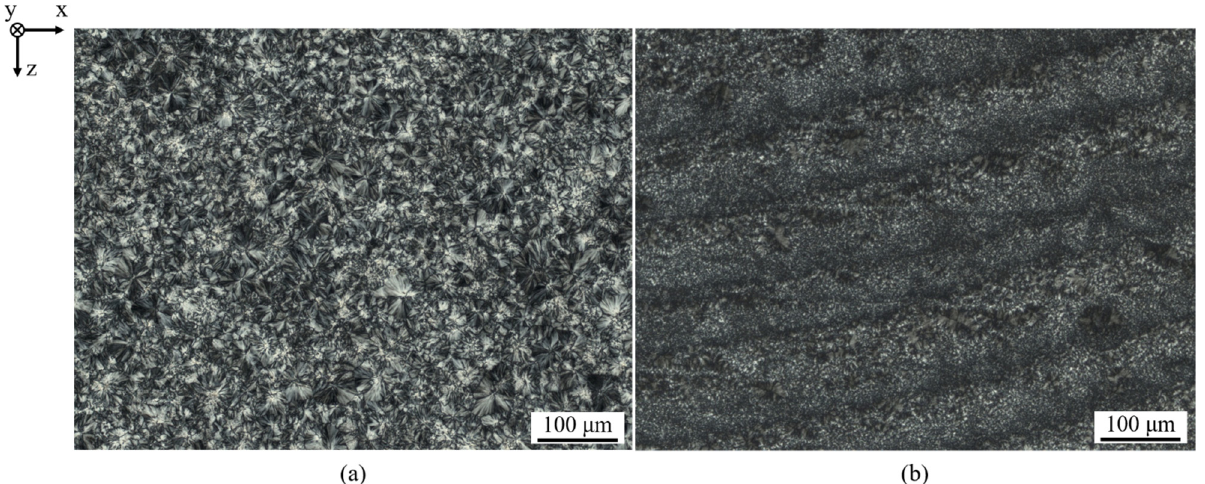
Figure 11. Polarization micrographs of Polyamide 12 specimens manufactured applying isothermal (T B = 170 °C, v = 2000 mm s − 1 , P = 16 W, d hatch = 0.2 mm) ( a ) and non-isothermal (T B = 75 °C, v = 500 mm s − 1 , P = 2 W, d hatch = 0.2 mm) ( b ) processing.